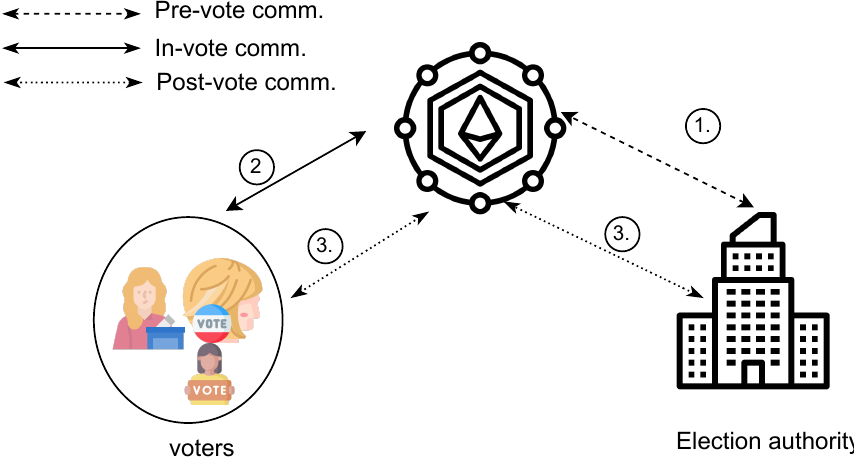
Figure 2. System architecture: (1) An organization publishes an election contract to the Blockchain. (2) The voter casts his/her vote to the Blockchain. (3) The Blockchain computes the results of the election and publishes the results to the candidates and